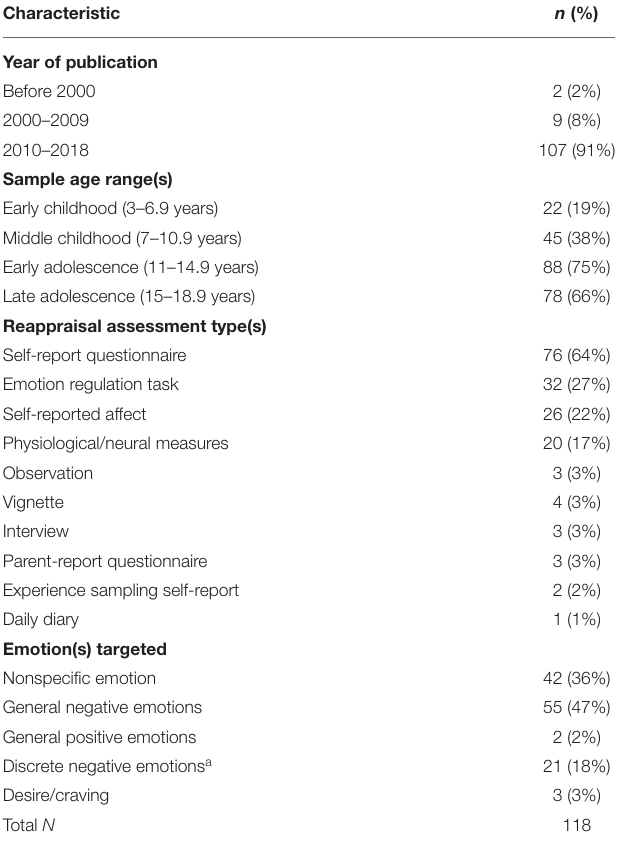
TABLE 2 | Characteristics of studies included in the systematic